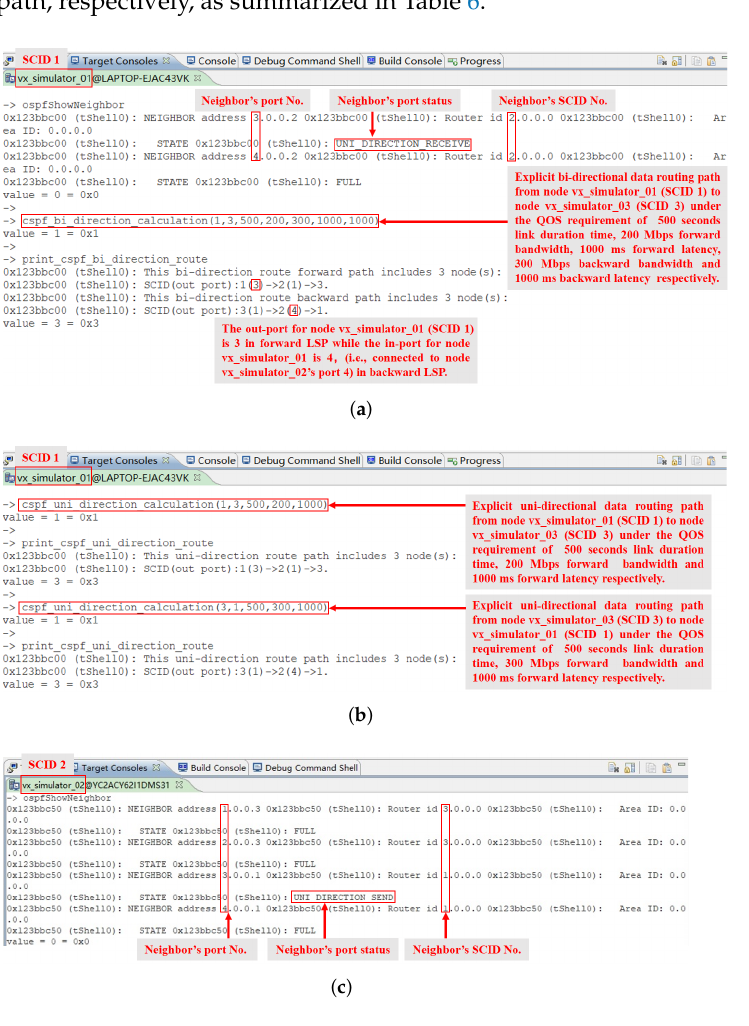
Figure 24. The explicit constraint data routing computation under QoS requirements and the circum- stances of uni-directional link between node vx_simulator_01 (ingress LER, SCID 1, uni-directional send- ing), node vx_simulator_02 (LSR, SCID 2, uni-directional receiving), and node vx_simulator_03 (egress LER, SCID 3). ( a ) The status of a neighbor’s port and data routing computation in node vx_simulator_01. ( b )The explicit uni-directional data routing path computation between node vx_simulator_01 and node vx_simulator_03. ( c ) The status of a neighbor’s port in node